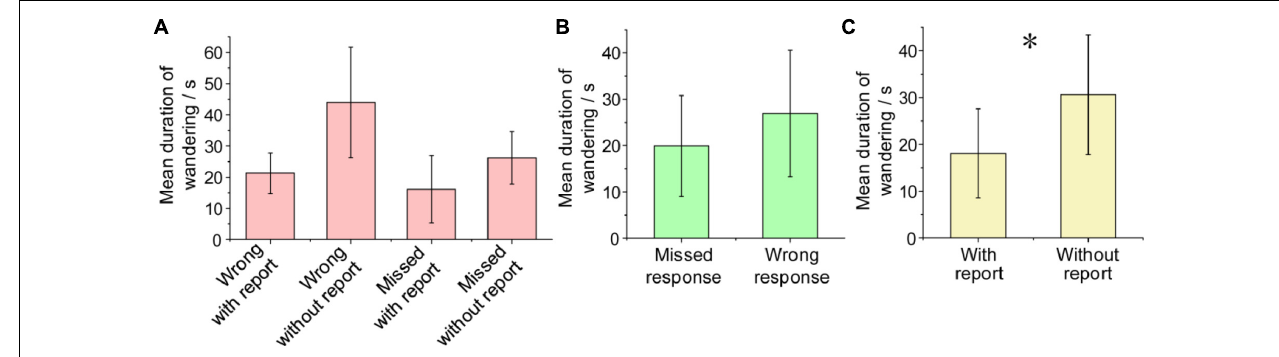
FIGURE 7 | Mean duration of mind wandering for error trials in different conditions. (A) Mean duration of mind wandering from all participants, grouped by four conditions of trials. (B) Mean duration when participants made wrong responses was longer than that when they missed responses. (C) Mean duration for error trials without self-report was significantly longer than that with self-report. ∗ p < 0.05. Error bars indicate ± SD